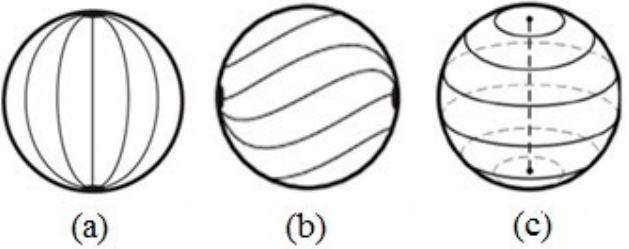
Figure 5. Director’s field schematization for a spherical droplet in planar anchoring conditions: ( a ) bipolar configuration, ( b ) twisted bipolar configuration ( c ) defect line along the diameter of the drop. Reprinted with permission from ref. [36]. Copyright 2011, Springer Nature.